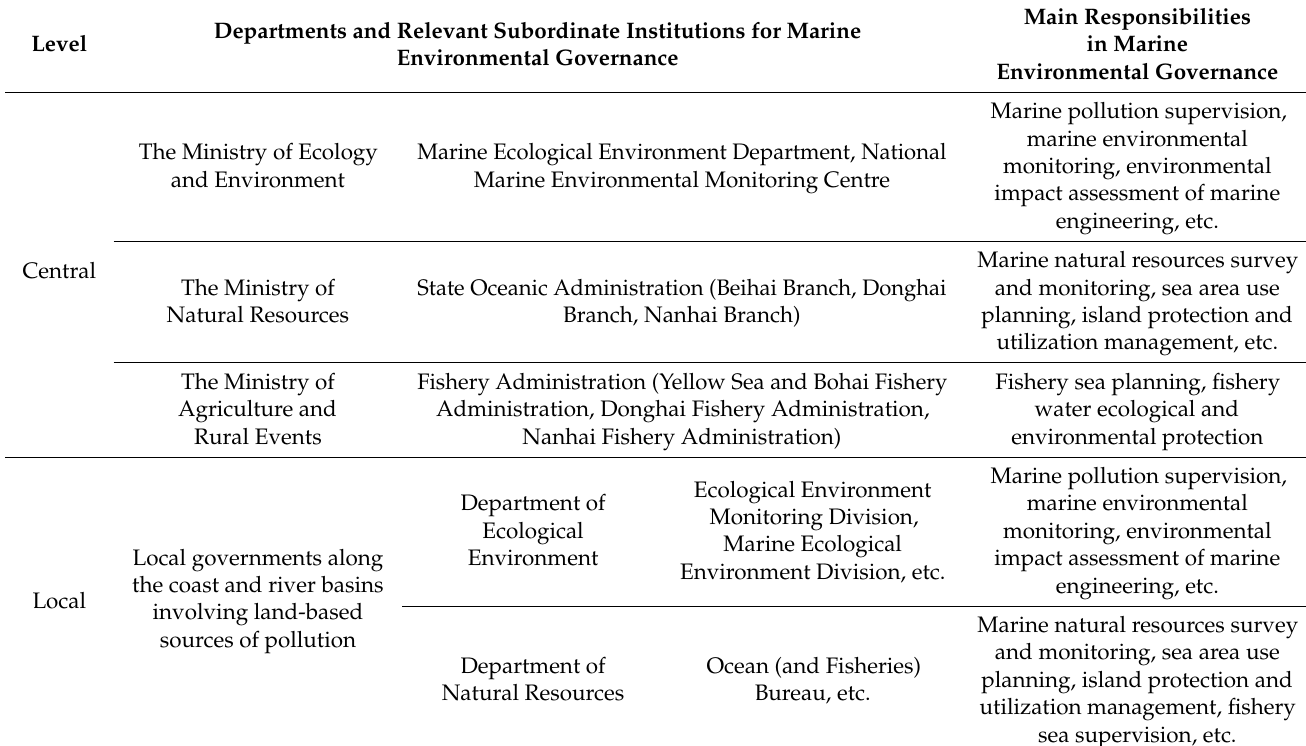
Table 1. Classification of central and local government entities involved in marine environmental governance after institutional